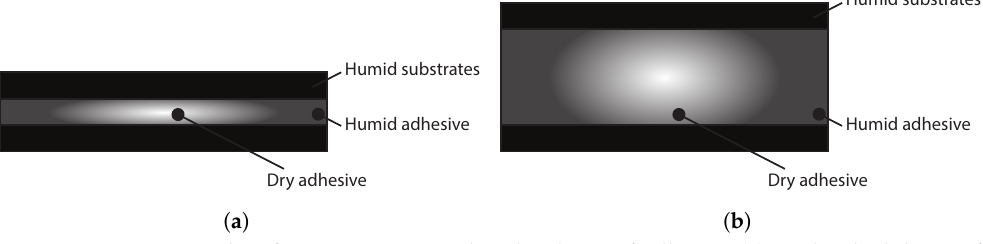
Figure 13. Water uptake of PBT-GF30 RJs with a thin layer of adhesive ( a ), and a thick layer of adhesive ( b ) as expected from the numerical model.